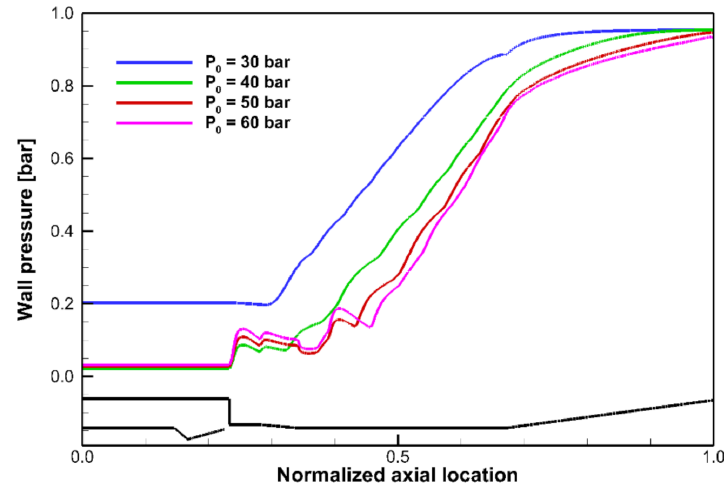
Figure 6. Wall pressure of the baseline diffuser at various operating pressures.